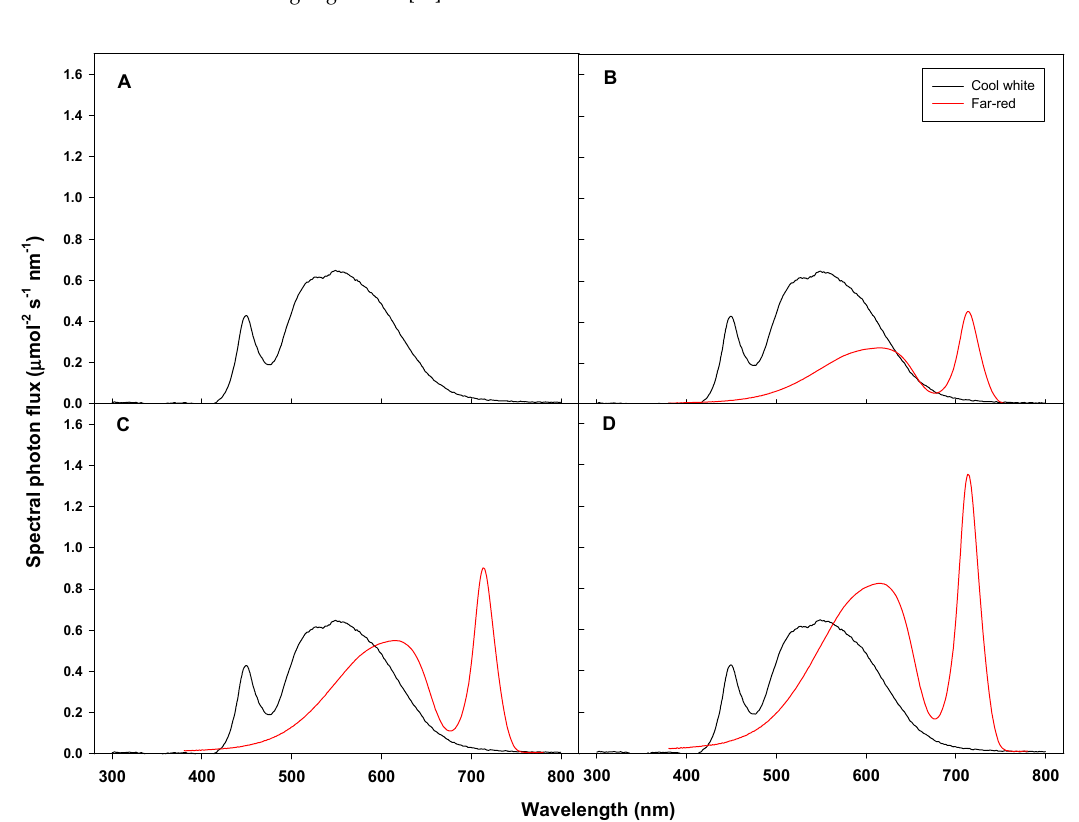
Figure 1. Spectral distribution of the light treatments W5F0 ( A ), W5F1 ( B ), W5F2 ( C ) and W5F3 ( D ).